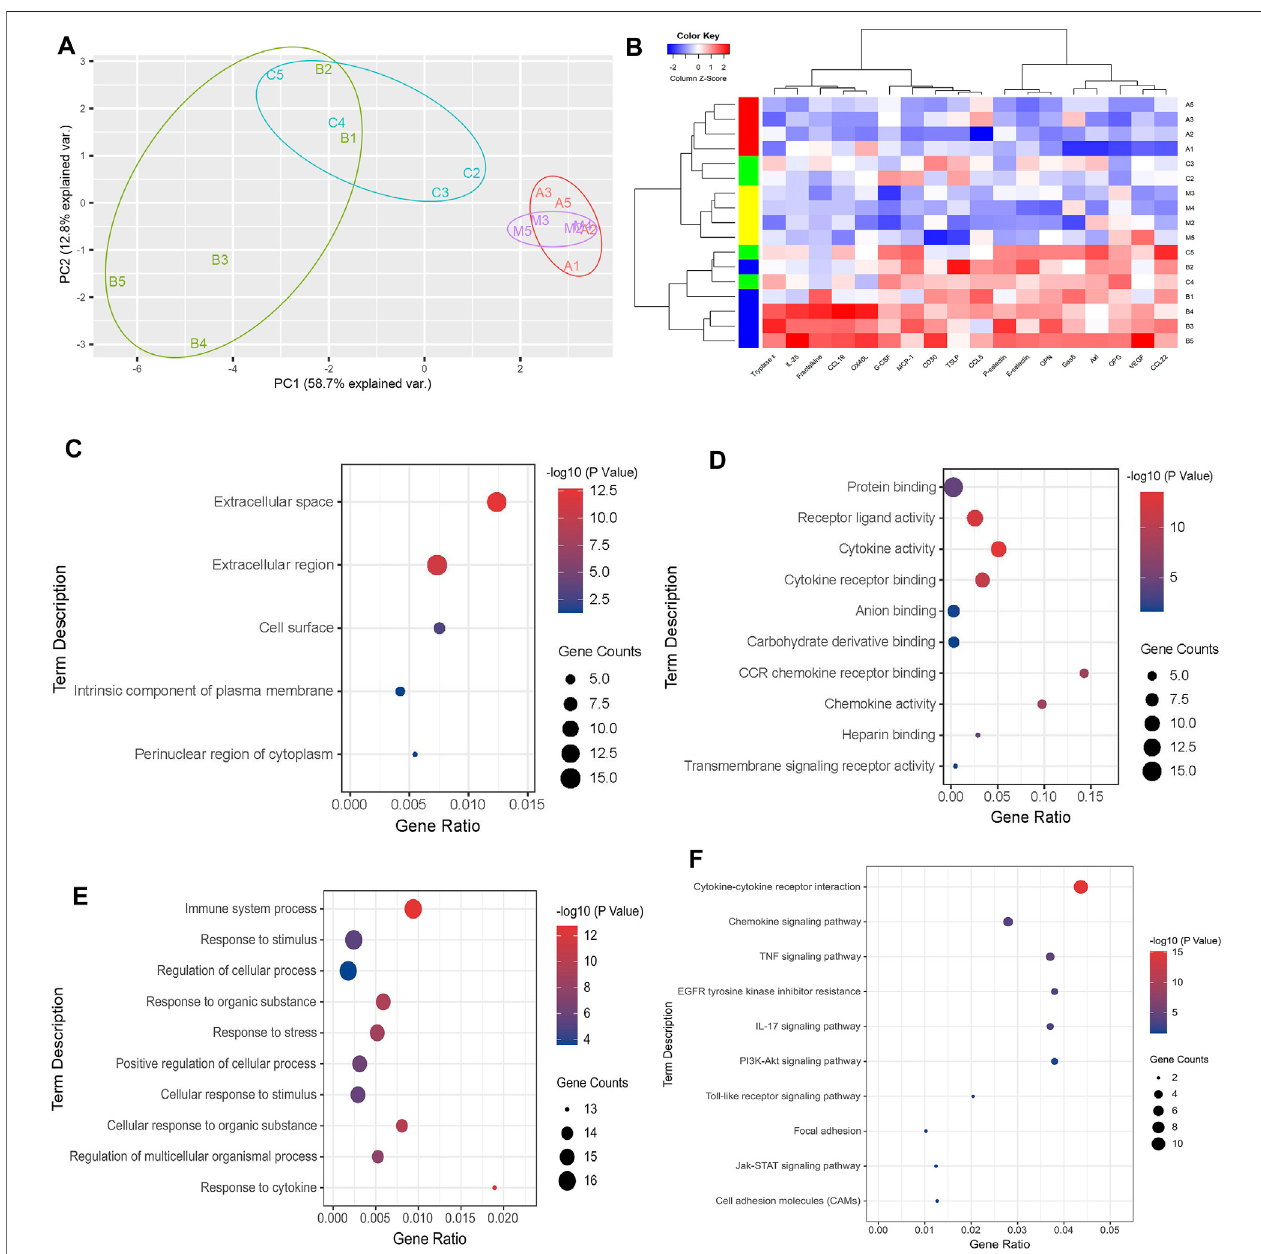
FIGURE 7 | (A) Principal component analysis of differential expressed proteins. (B) Clustering analysis of differential expression proteins, A: NC group, B: OVA group, C: OVA + DEX group, D: OVA + TMDCD group. The color key indicates the protein expression level: red represents high-level expression, blue represents low- levelexpression. (C) GOpathwayenrichmentanalysisofCC. (D) GOpathwayenrichmentanalysisofMF(top10). (E) GOpathwayenrichmentanalysisofBP(top10). (F) KEGG pathway enrichment